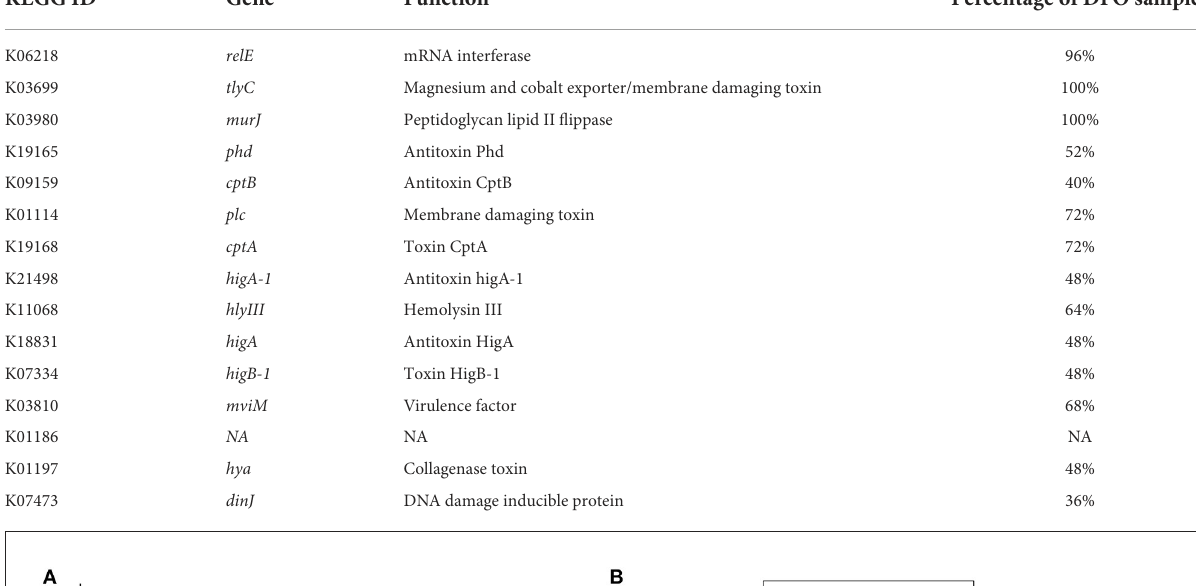
TABLE 1 Top expressed transcripts associated with pathogenesis.